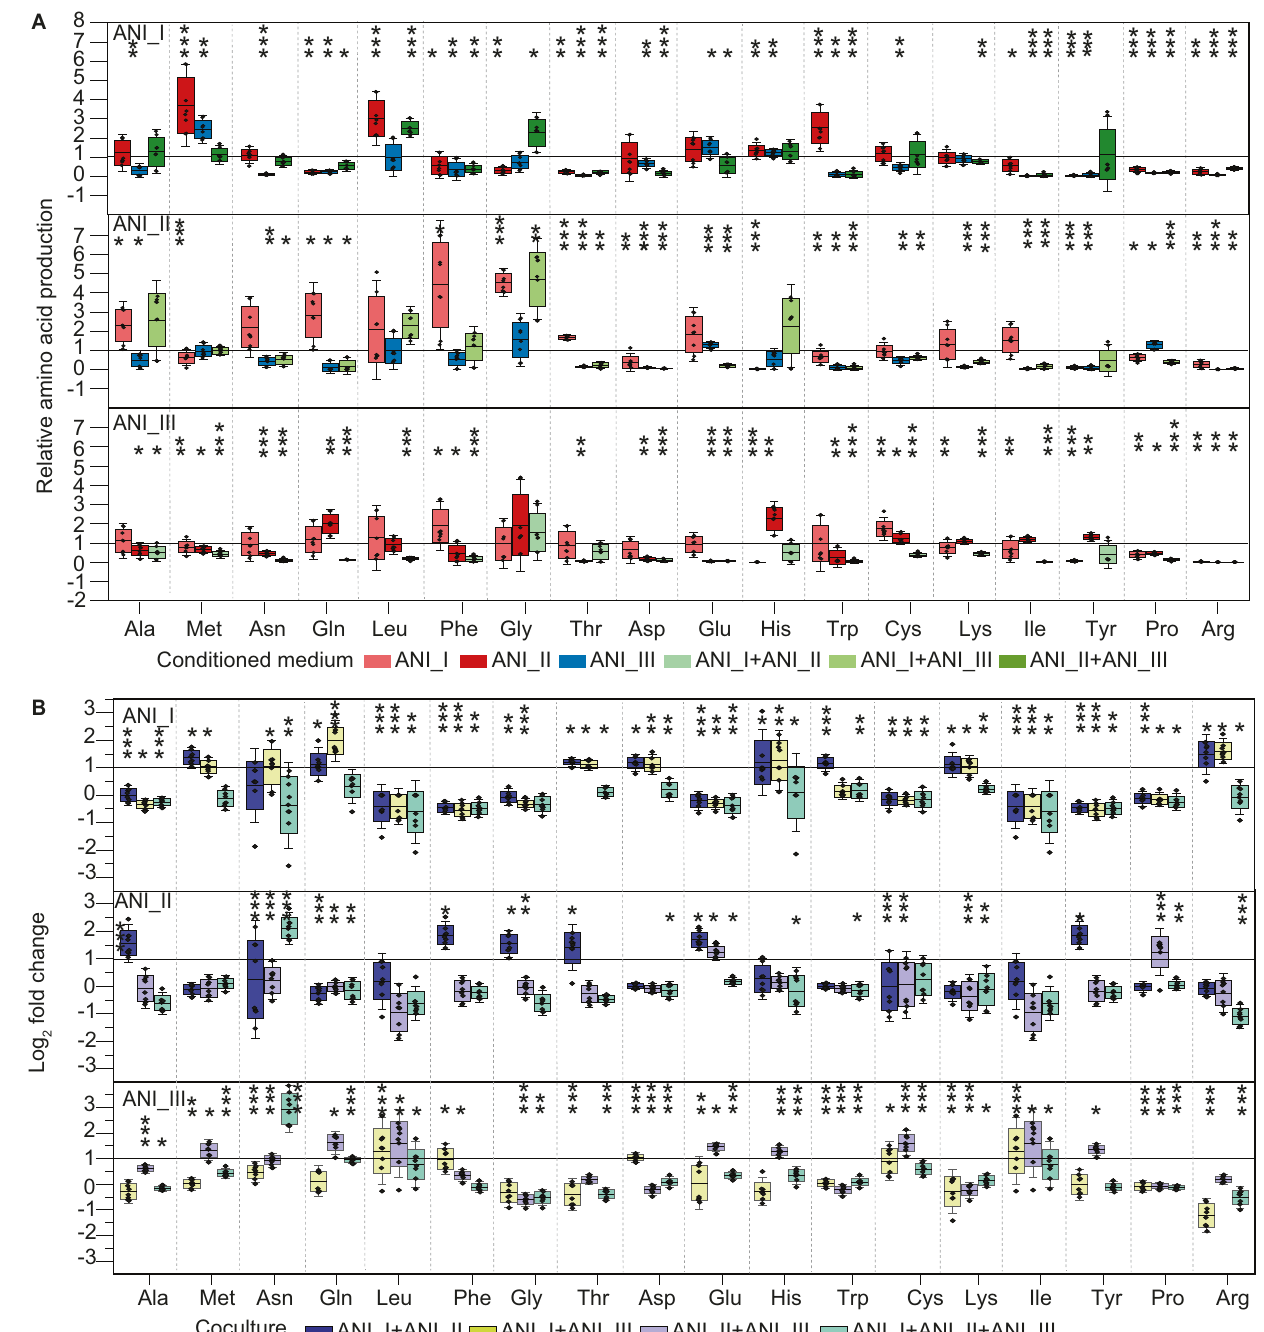
Fig. 4 Relative amino acid production in cultures with conditioned medium and the transcription of amino acid-related genes in cocultures. A The relative amino acid production of the ANI _I, ANI_II, and ANI_III groups in conditioned medium from the other genotypic groups. Scatter points indicate the relative production of amino acids of one isolate in conditioned medium. B The transcription of the last gene in the biosynthesis pathway of different amino acids in ANI _I, ANI_II, and ANI_III groups in coculture with other genotypic groups. Scatter points indicate the log 2 fold change level of transcriptional data of one isolate in coculture compared to monoculture. All the data were from two coculture experiment groups (isolate_1, isolate_4, and isolate_9; isolate_3, isolate_8, and isolate_9). Cultures were performed in Transwell plates (Supplementary Fig. 1) under static and anaerobic conditions at 30 °C. In the Transwell plate, cells of different genotypes can be separated in upper and lower chambers, and the medium can pass through membrane pores between the two chambers. The bacterial solution was collected on Days 0 and 8 for amino acid analysis in cultures with conditioned medium and on Day 4 for transcription analysis in cocultures. Error bars indicate the standard deviation of four biological replicates; asterisks represent signi fi cant differences in relative amino acid production between Day 8 and Day 0 ( t -test, * p < 0.05, ** p < 0.01, *** p < 0.001), and signi fi cant differences in gene transcription between coculture and monoculture (* adjusted p < 0.05, ** adjusted p < 0.01, *** adjusted p < 0.001, |log 2 fold change| >